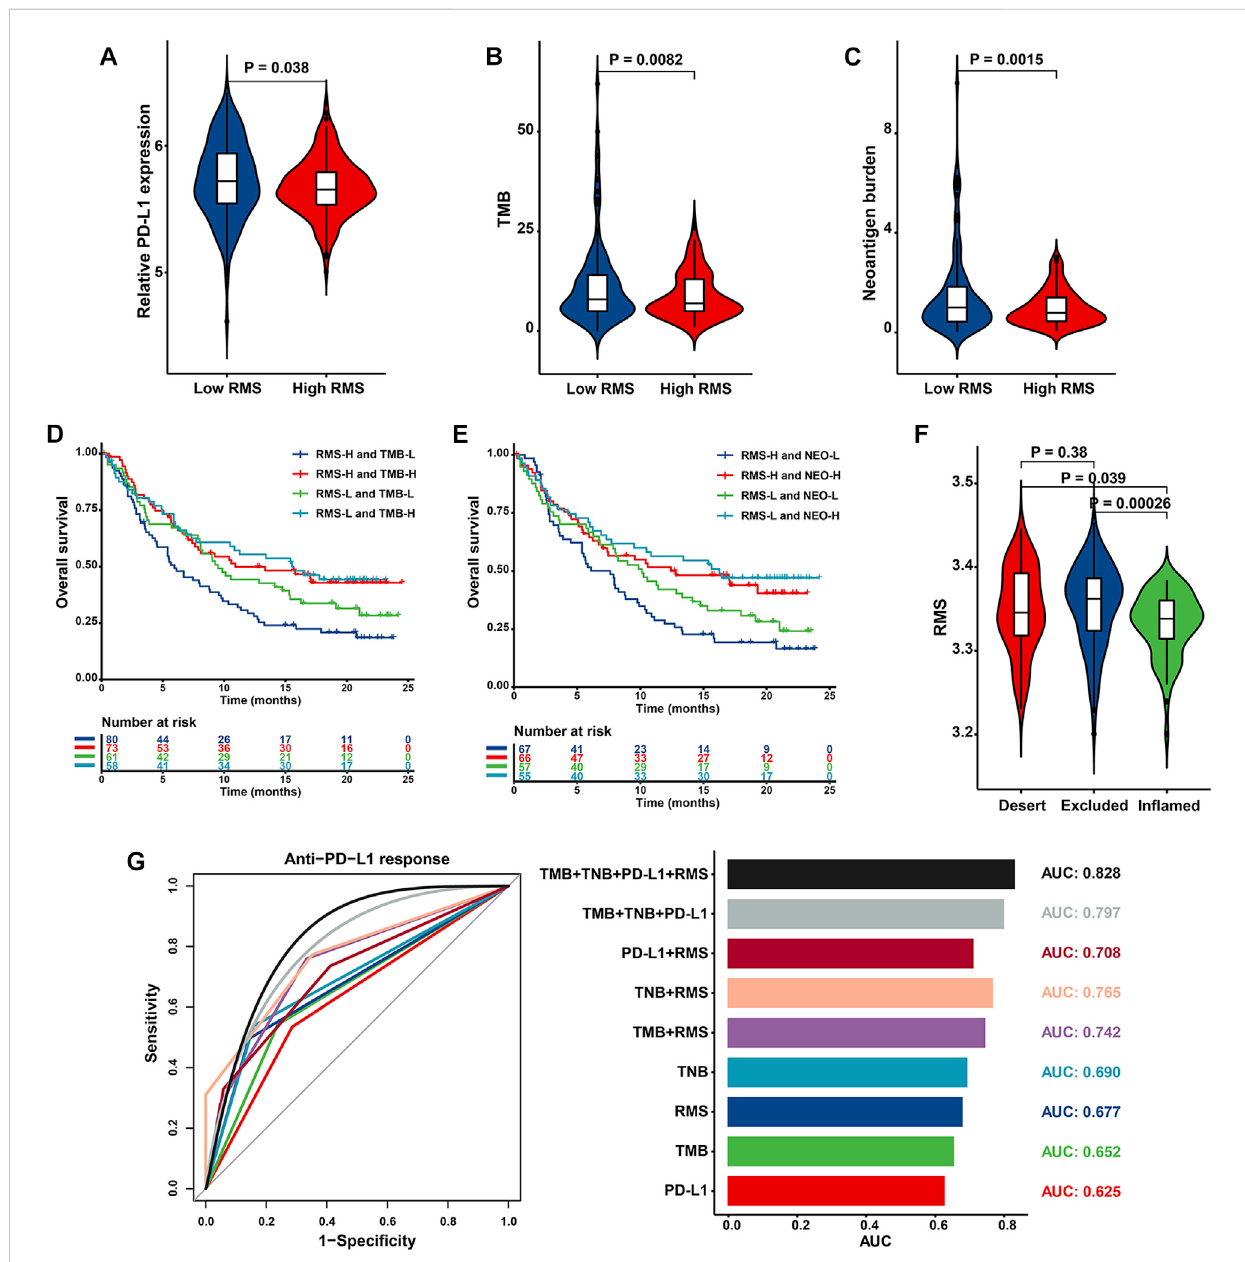
FIGURE 12 The biological signi fi cance and predictive value of RMS for the ef fi cacy of anti-PD-L1 immunotherapy in IMvigor210 cohort. Violin plot depicting differencesinthelevelsof (A) PD-L1, (B) TMB,and (C) neoantigenburdenbetweenRMS-lowand-highgroup.Kaplan-MeiercurveshowingOSofmultiple subgroups strati fi ed bythe RMS and (D) TMB or (E) neoantigen burden (F) Violin plotpresenting difference in theRMS among three immunephenotypes. (G) Histogram and ROC curve displaying the predictive power of nine signatures composed of TMB, TNB, RMS and